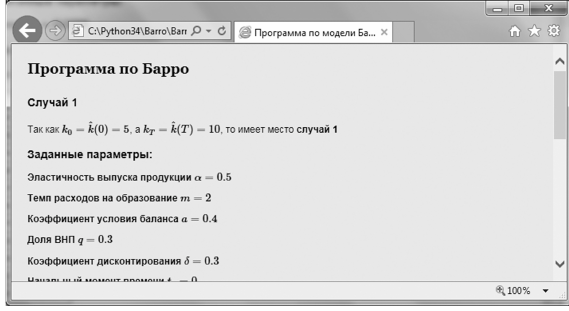
Fig. 6. HTML file generated by program.